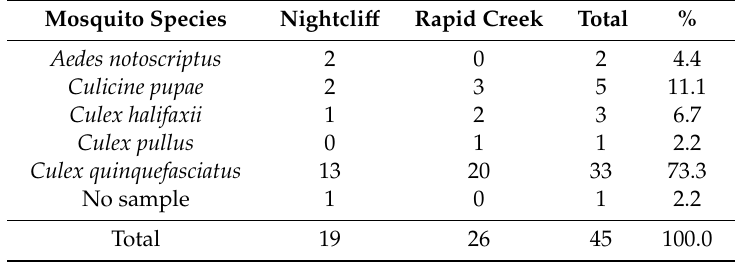
Table 2. Larval mosquito species identified in side entry pit sumps (n = 36).